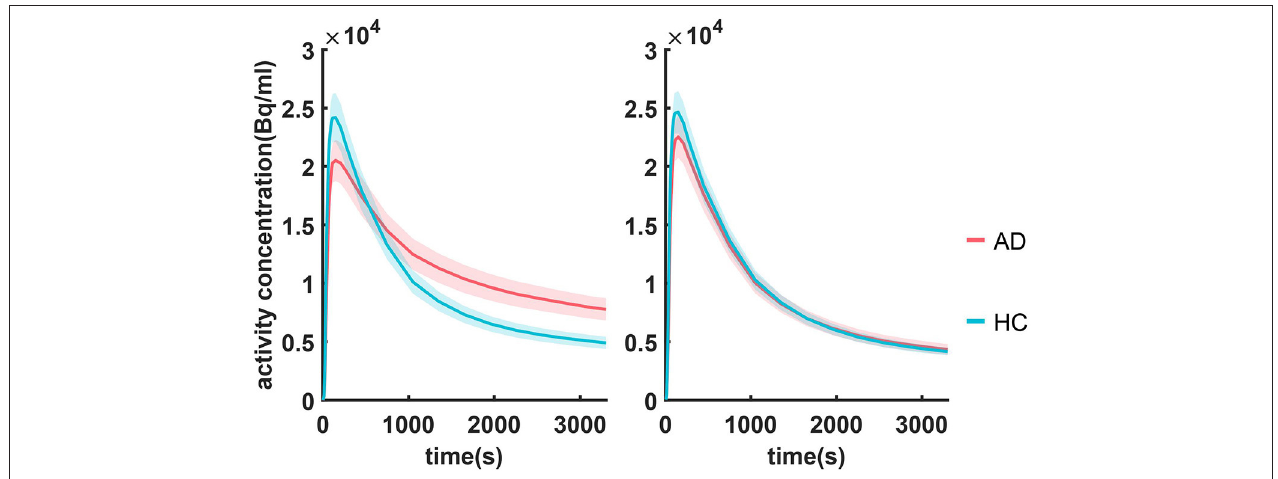
FIGURE 2 | Summarized TACs for all 120 subjects in (A) caudal anterior cingulate cortex and (B) cerebellar cortex. The solid lines indicate that the mean value in each group and the shadowed areas indicate 95% confidence interval.